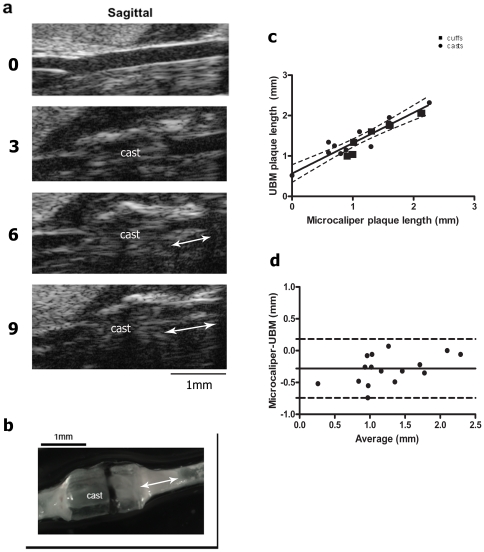
Plaque length is accurately measured by ultrasound.(a) Representative sagittal B-mode images of RCCA from one animal prior to surgery (0) and 3, 6 and 9 weeks after cast placement. Plaque length is indicated with arrows. (b) Whole mount of the carotid artery in (a) at study termination. (c) Linear regression of ultrasound vs microcaliper measurements of plaque length (n = 6 cuffs, 10 casts). Dotted lines indicate 95% confidence intervals. Correlation coefficient = 0.92, n = 16. (d) Bland Altman analysis of plaque length as measured by microcaliper and UBM. Dotted lines represent 95% limits of agreement. Bias, indicated by solid line, was calculated as −0.27 mm+/−0.22 SD.